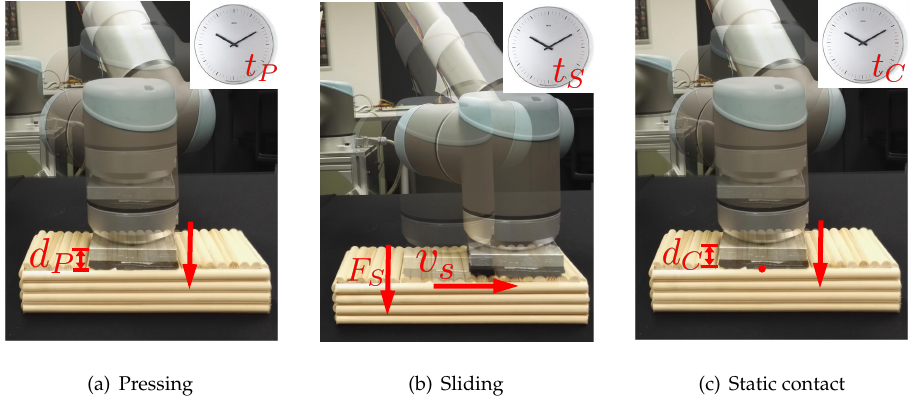
Figure 3. The figure visualizes multiple exploratory actions. ( a ) The pressing movement defined by the action parameters d P and t P ; ( b ) The sliding movement with action parameters v S , F S , and t S ; ( c ) The static contact movement defined by d C and t C